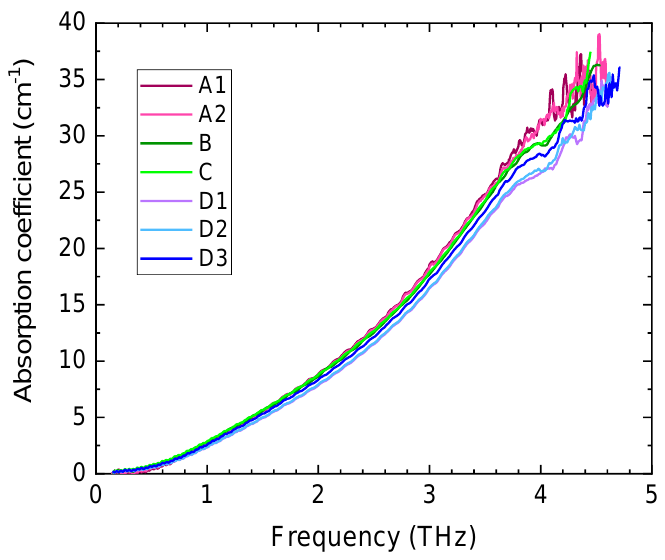
Figure 7. Refractive indices of Spectrosil 2000 silica glass samples.